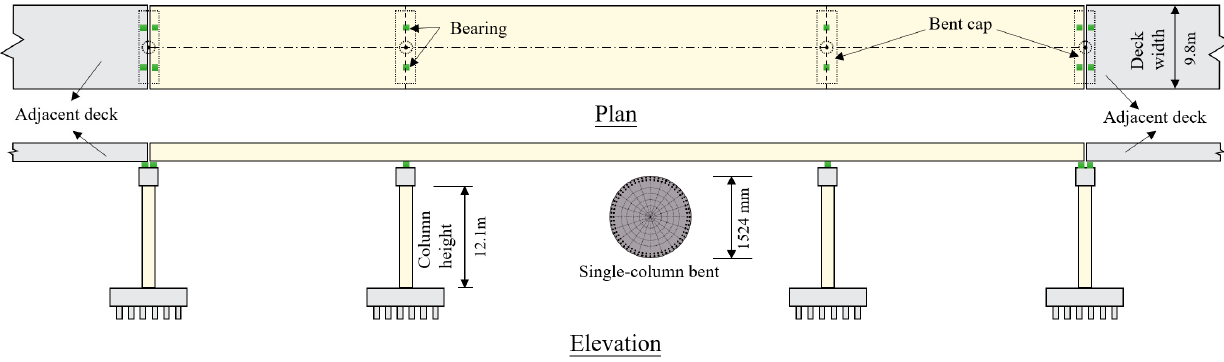
Figure 7. Schematic illustration of the bridge layout. The bridge was modeled using OpenSees Finite element code [38], as shown in Figure 8. It is noted that only the seismic performance of the middle unit of the bridge is investigated here, with the other two units being the boundary conditions. The critical column, i.e., the third column from the left, was modeled using the previous deterioration modeling technique. Additionally, the soil-structure interaction effects were considered. The first two natural vibration periods in the longitudinal direction of the FE model of the bridge were 0.99 s and 0.17 s, reflecting the bridge’s dominant first mode of